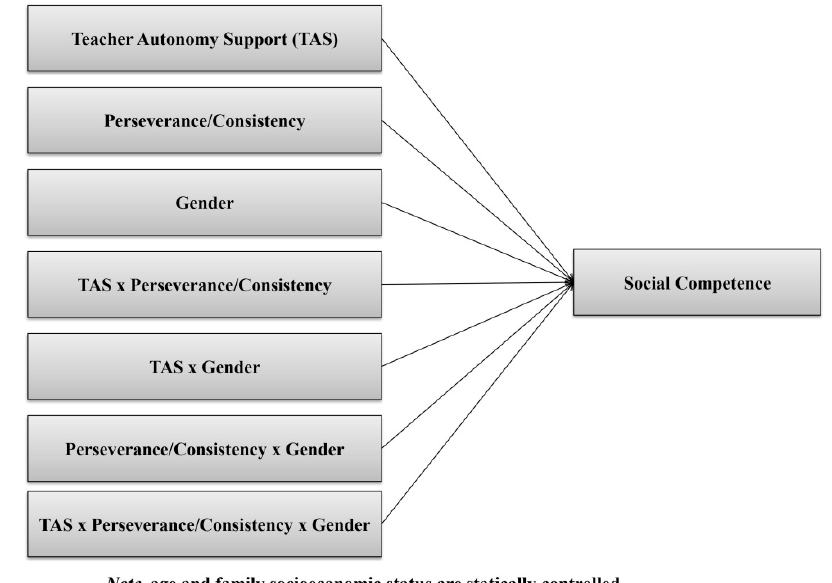
Figure 1. A hypothesized model of the direct and interactive associations of teacher autonomy support, two dimensions of grit, and students’ gender with social competence. Note: We conceptually regard teacher autonomy support as an independent variable and the two dimensions of grit and students’ gender as moderators. Although the interaction between two moderators (i.e., Perseverance/Consistency × Gender) on social competence is not our research focus, it should be established as one of the necessary steps to create a three-way interaction term.